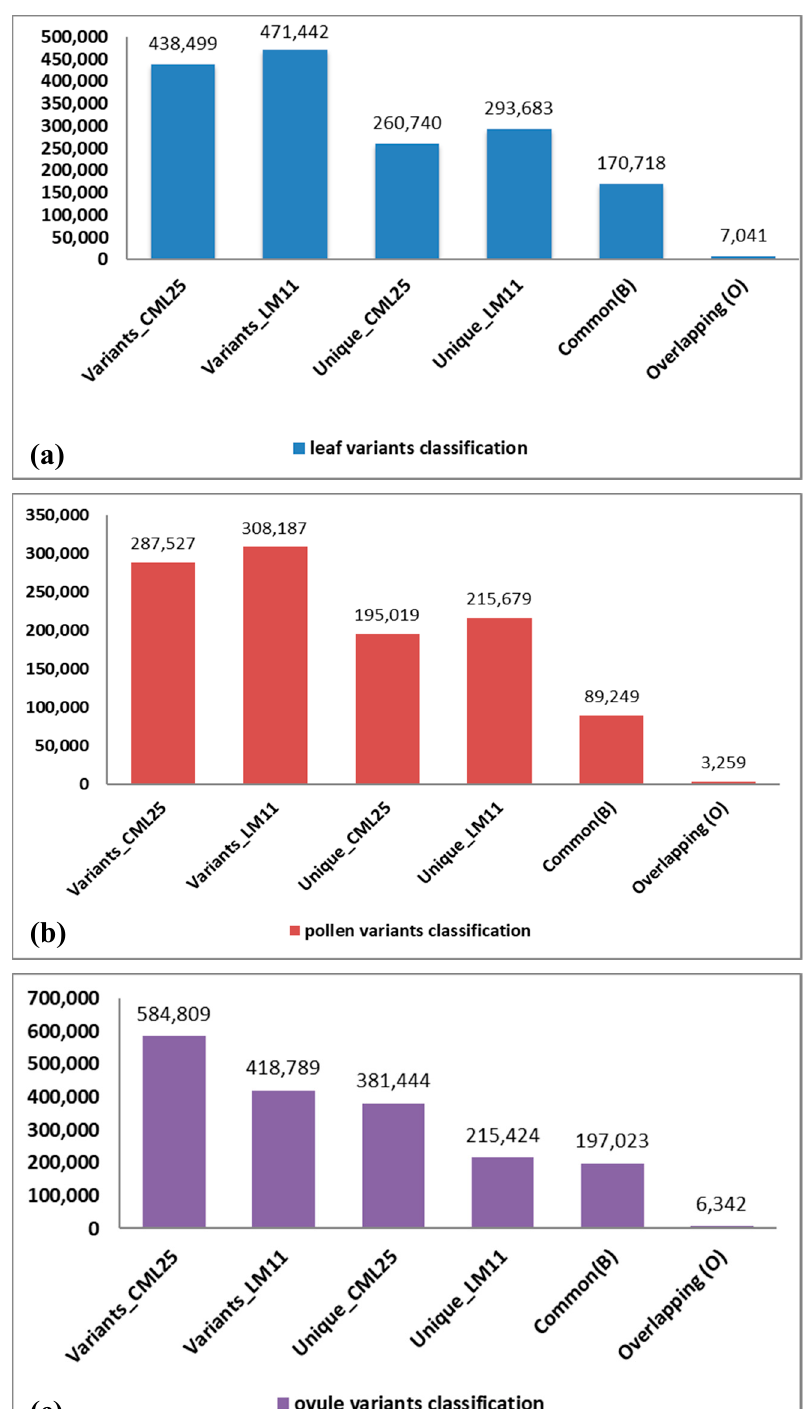
Figure 3. Classification of variants into different categories in CML25 and LM11. ( a ) leaf variants, ( b ) pollen variants, ( c ) ovule variants.